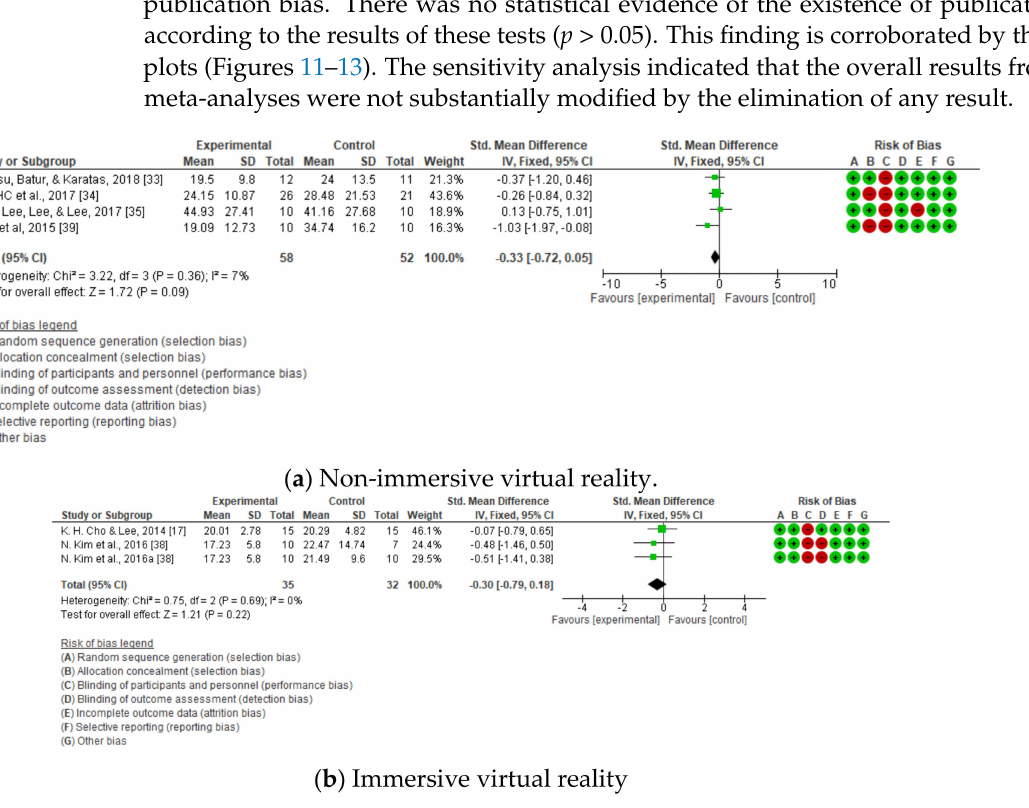
Figure 6. Dynamic balance as measured using the timed up and go test. ( a ) Non-immersive virtual ( b ) Immersive virtual